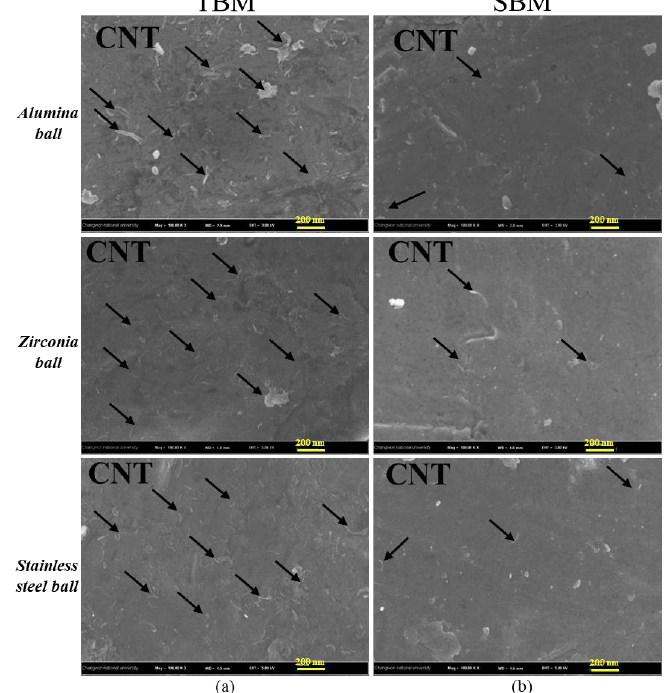
Figure 11. FESEM images (100,000 × ) of Cu / CNT nanocomposites for 48 h at 300 rpm in both mills ( a ) TBM and ( b ) SBM with three different milling media.